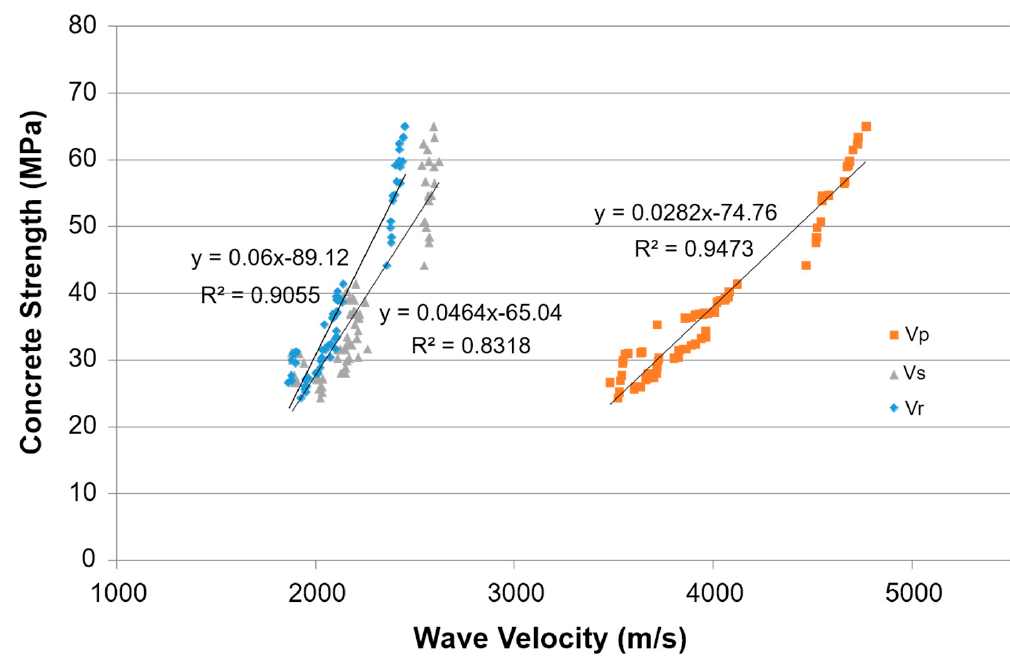
Figure 8. Relationship of P-, S-, and R-wave velocities with concrete strength.